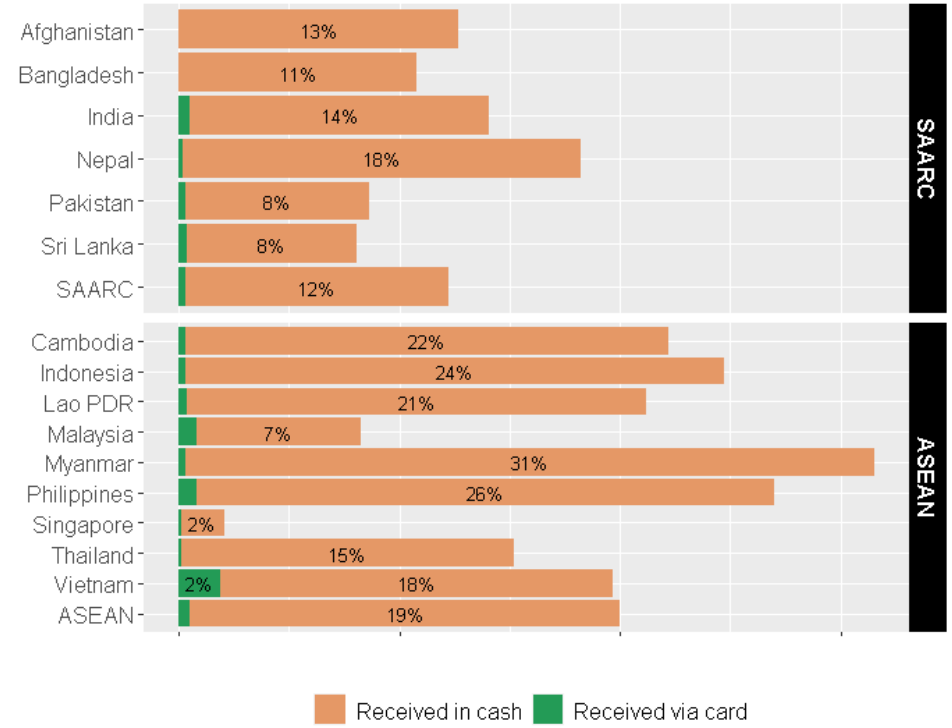
Figure 12. Percentage of participants who received money from employers in cash or via card.